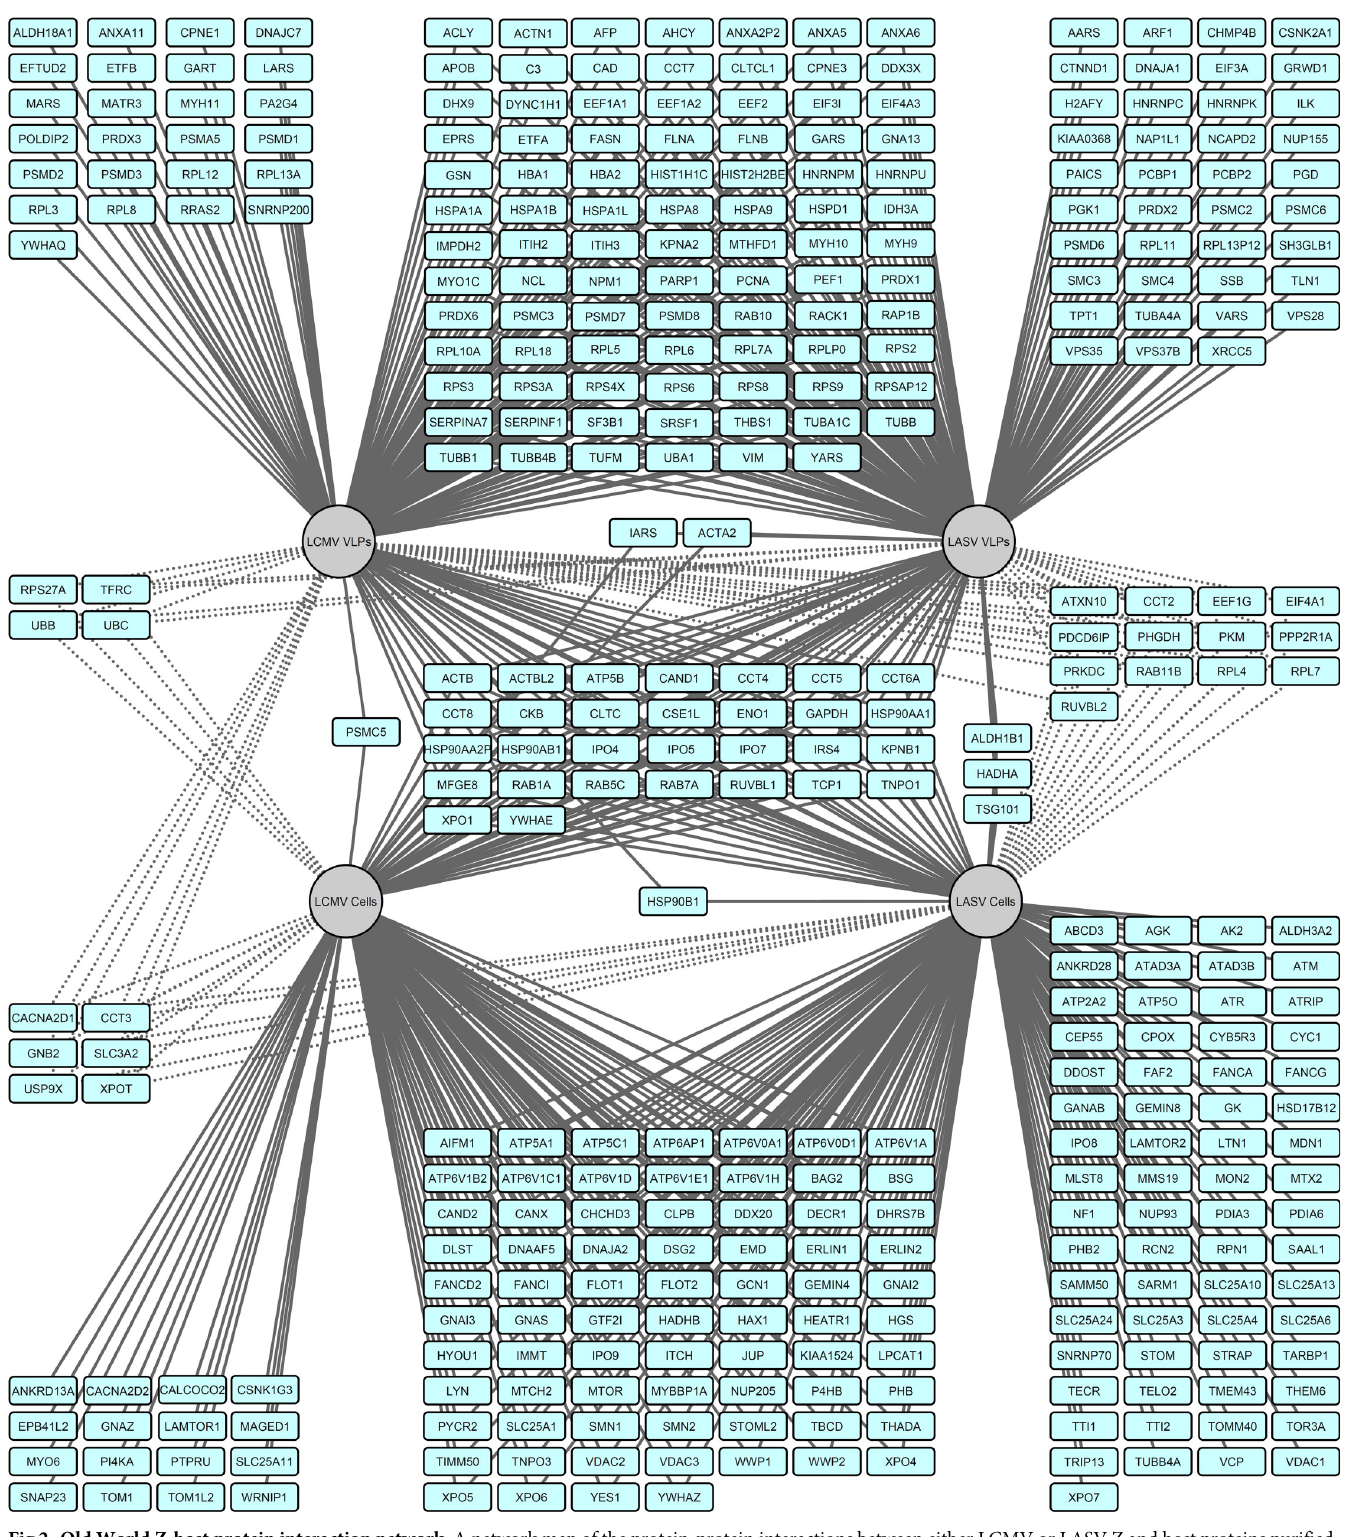
Fig 2. Old World Z-host protein interaction network. A network map of the protein-protein interactions between either LCMV or LASV Z and host proteins purified from cells or VLPs was generated using Cytoscape 3.2.1 software. Only proteins identified in both biological replicate experiments are depicted on the map. Solid lines indicate host proteins identified in 1, 2, or 4 conditions and dashed lines indicate host proteins identified in 3 conditions.